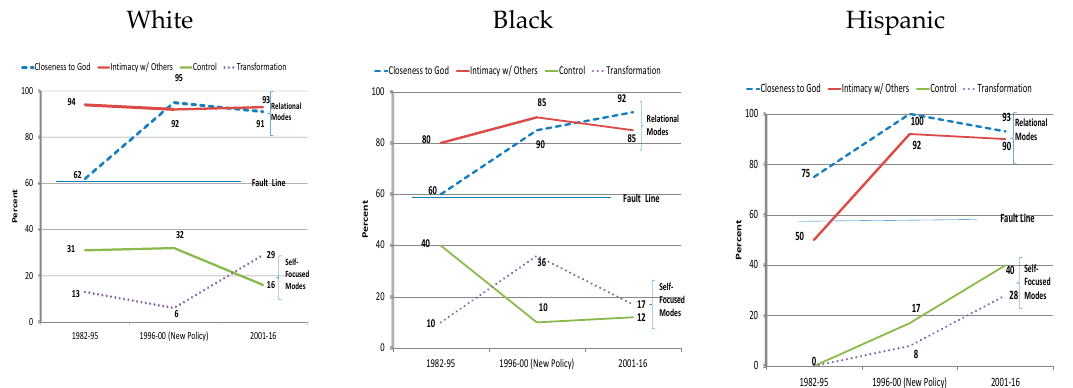
Figure 3. Hierarchy of Religious Coping Methods as a Proportion of all Religious Last Statements among Texas Death Row Inmates by Race, Ethnicity, and Time Period (7 December 1982–6 April 2016), (N = 269).